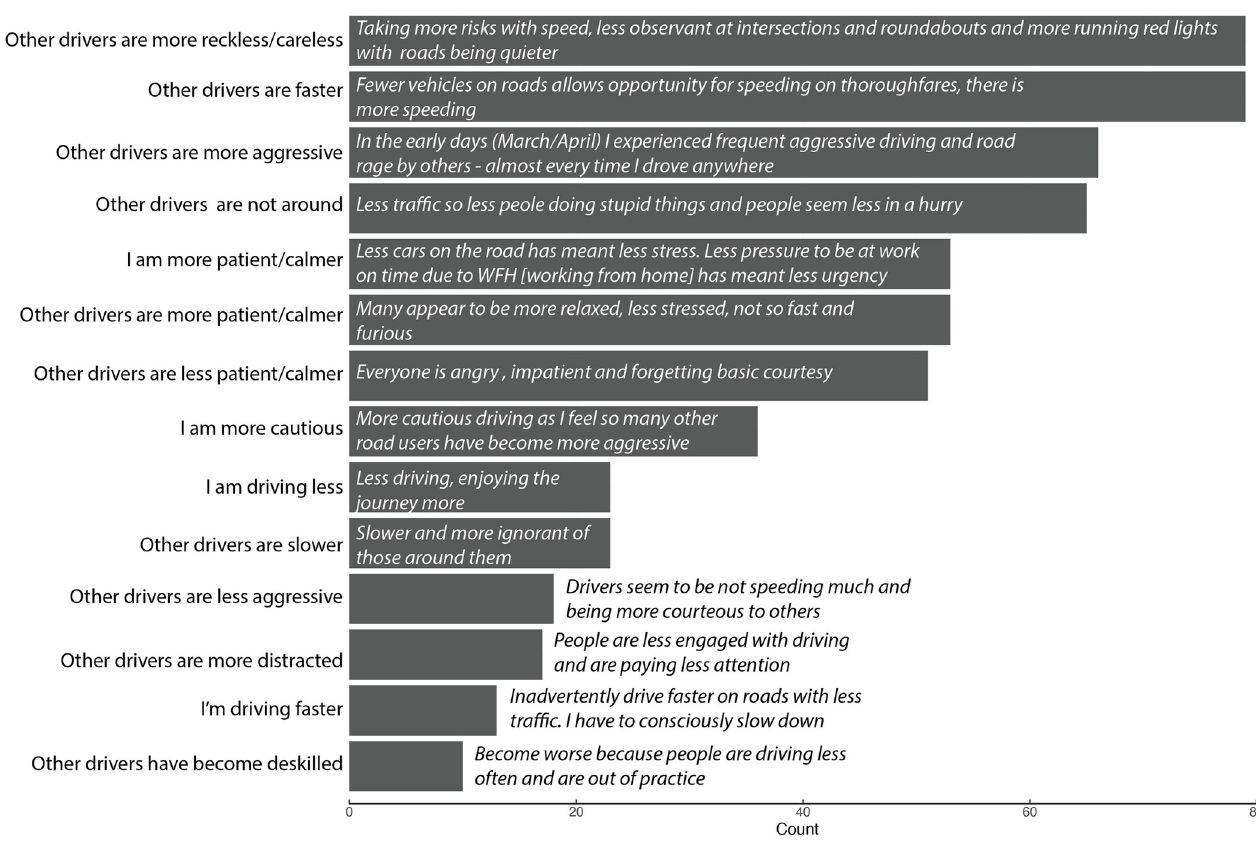
Fig 2. Summary of themes that emerged from coding the text responses to questions regarding changes in driving during the COVID-19 lockdown (regarding oneself and others). Each theme is ordered by frequency and is presented with an illustrative quote.